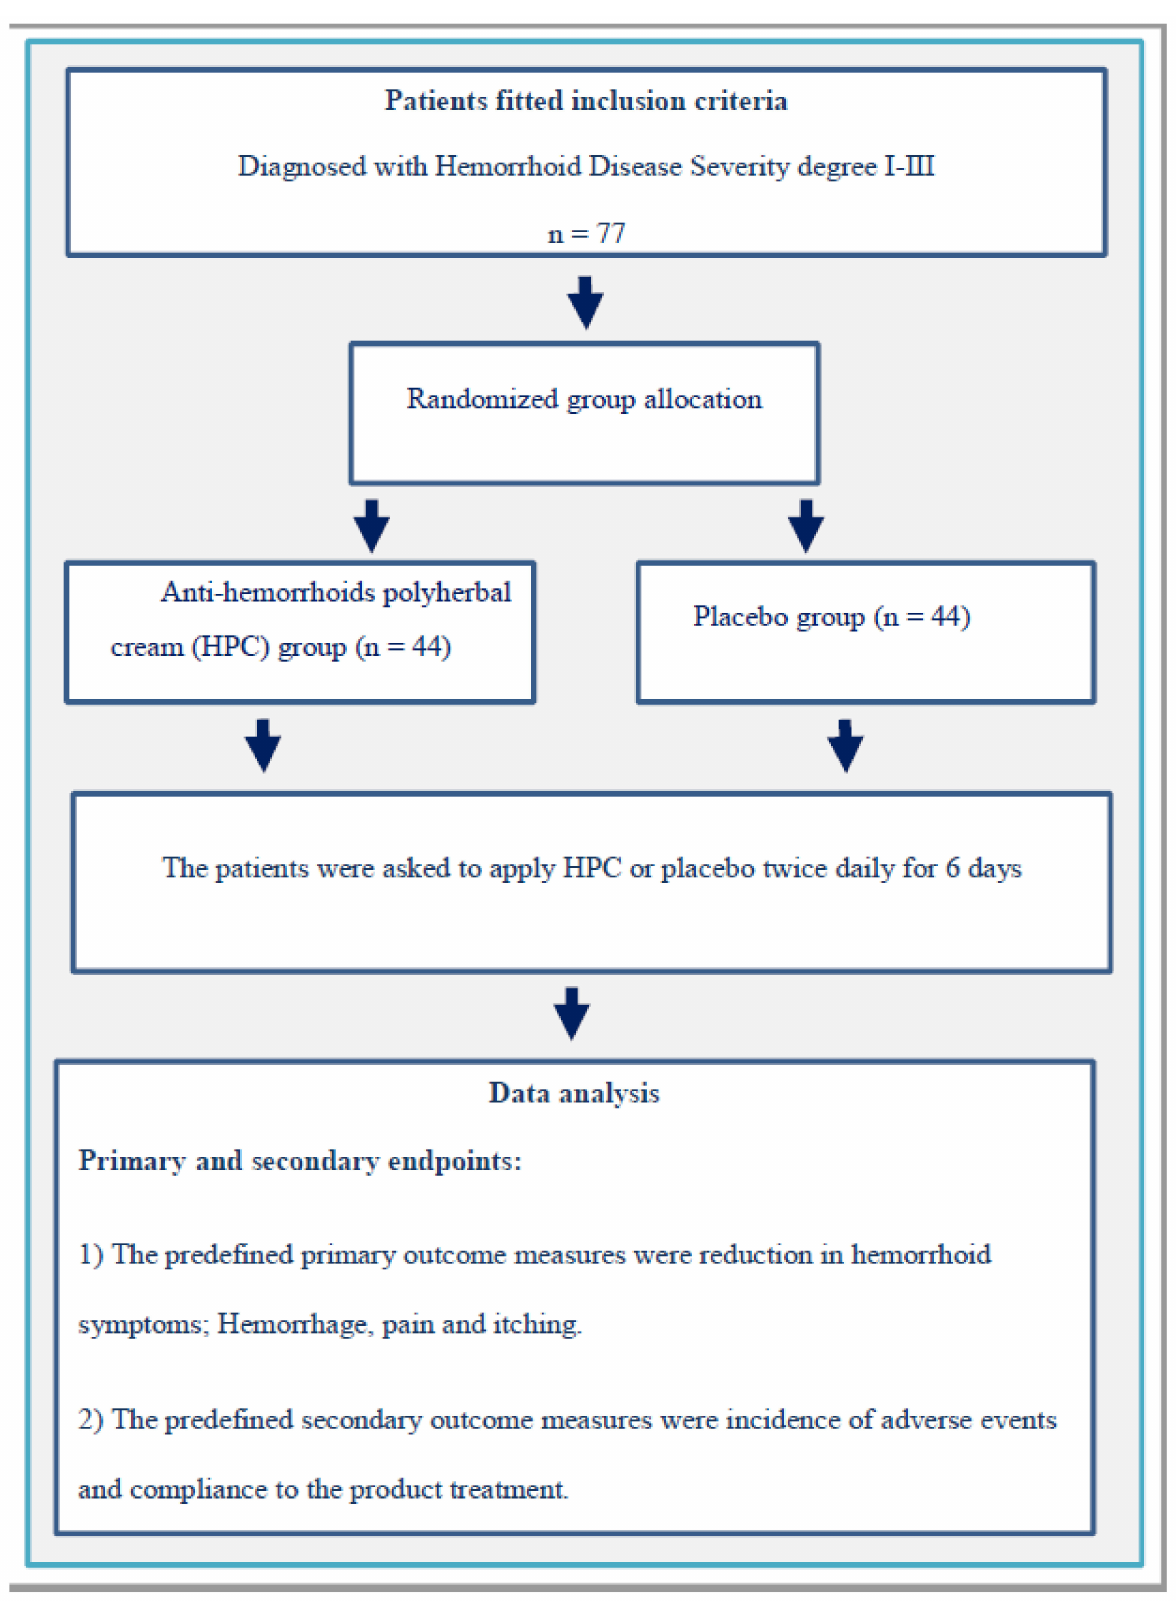
Figure 1. A flow chart of the randomized, double-blind, placebo-controlled clinical trial procedure. Exclusion Criteria: (1) History of inflammatory bowel disease. (2) History of irritable bowel syndrome with constipation or diarrhea. (3) Previous surgical or